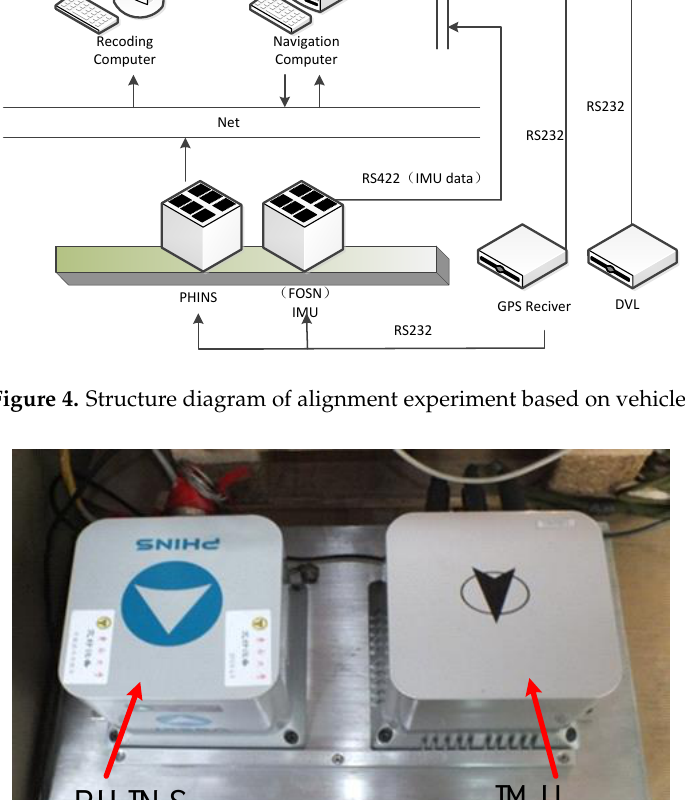
Figure 7. Attitude error curves of coarse alignment (the swing center of heading is 45°). ( a ) The error curves of pitch angle; ( b ) the error curves of roll angle; ( c ) the error curves of heading angle. Figure 7 shows that the convergence rate of that quaternion filter algorithm is so slow that it is not suitable for practical use. The horizontal attitude accuracies of the optimal quaternion algorithm and the improved quaternion filter algorithm are similar to one another. The means and standard deviations of their alignment errors for heading are respectively 0.1431° and 0.1232°, and 0.1302° and 0.0315°. Although the mean values of two algorithms are close, the standard deviation of the latter is much smaller than the former because the latter is more stable. In order to thoroughly compare the alignment effects of the optimal quaternion algorithm and the improved quaternion filter algorithm, the errors are shown at three alignment moment, such as 50 s, 80 s, and 100 s, in Table 2. 20